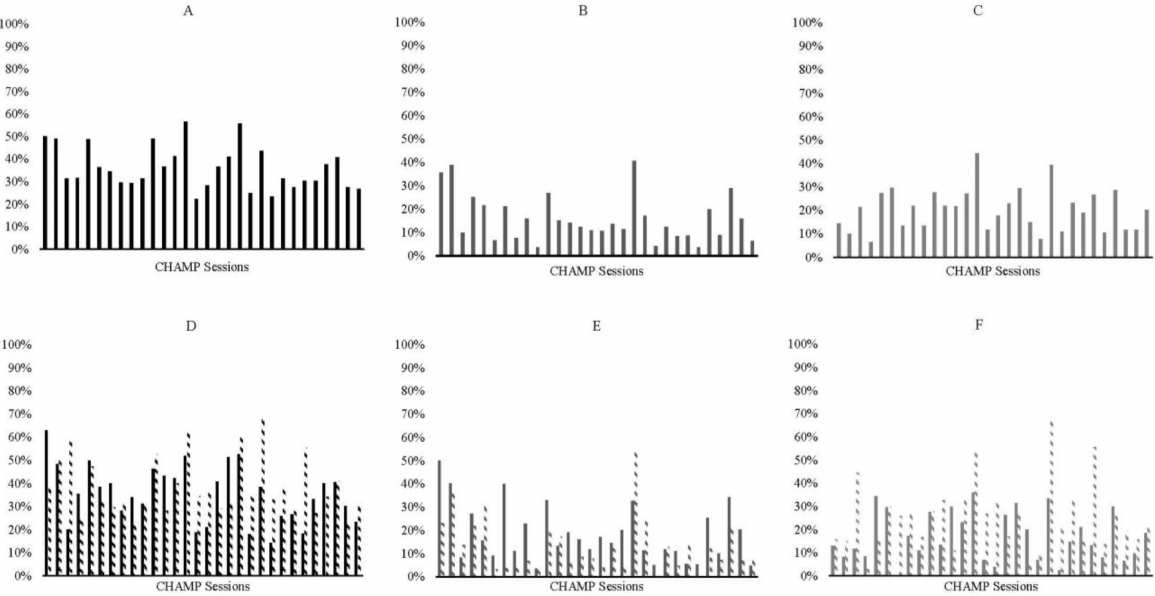
Figure 1. Graphs representing all children’s engagement across the 30-intervention sessions. In all plots, percentage of engagement is plotted on the y-axis and session number if on the x-axis. Plots include ( A ) all skills, ( B ) locomotor skills, ( C ) ball skills, ( D ) all skills for children with below average initial skills and average and above average initial skills, ( E ) locomotor skills for children with below average initial skills and average and above average initial skills, and ( F ) ball skills for children with below average initial skills and average and above average initial skills. For graphs ( D – F) , children with below average initial skills are plotted in solid bars and children in average & above average initial are plotted in dashed